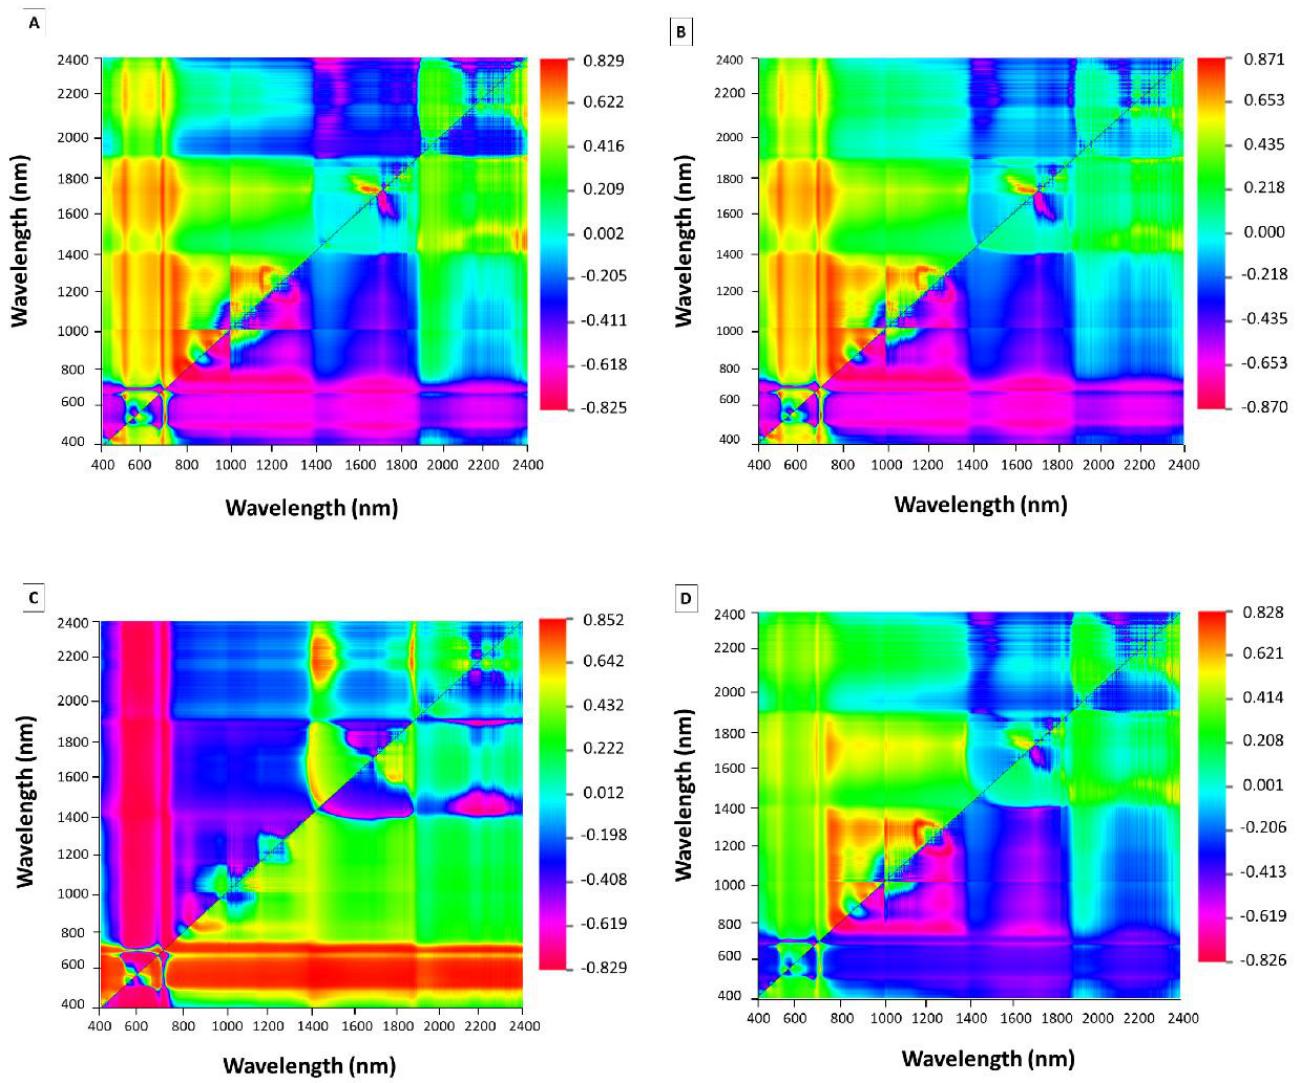
Figure 7. Two-dimensional correlogram between spectral reflectance and the leaf phosphorus ( A ), potassium ( B ), calcium ( C ) and zinc ( D ) content.